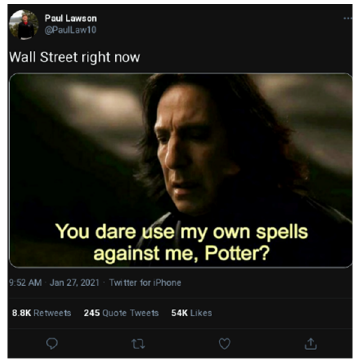
Figure A2. A meme recognizes meme investors’ short squeezing as a mimic of traditional financial institutions’ speculative culture. https://www.menshealth.com/entertainment/a35354744/gamestop- stock-memes/, accessed on 18 December